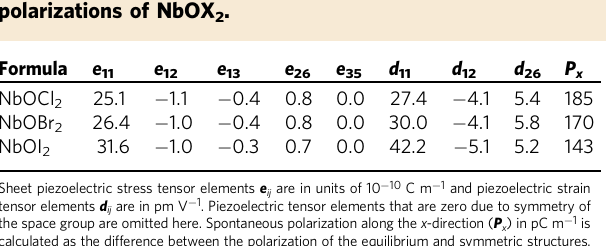
Our computed in-plane dielectric constant of NbOX 2 is 12 – 15 (see Supplementary Table S6).